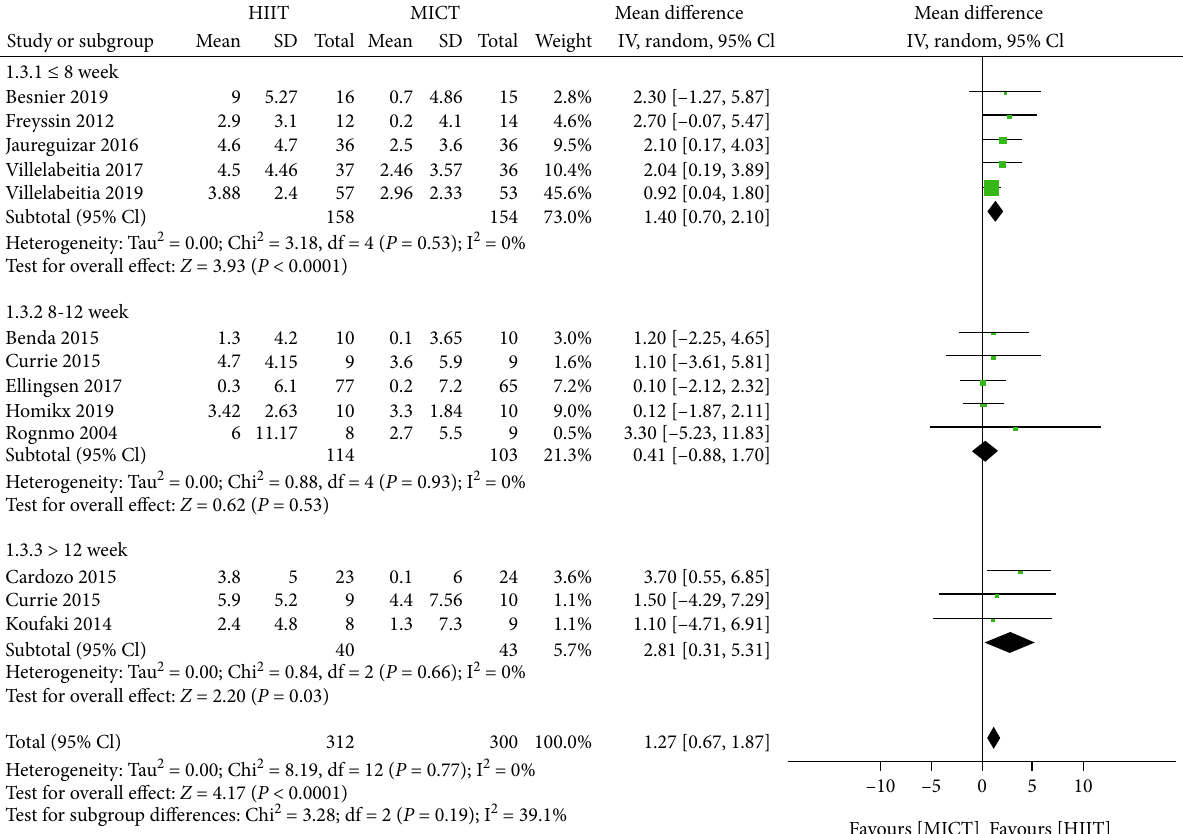
according to training duration ( ≤ 8weeks, 8-12weeks, and ≥ 12weeks). HIIT: 2 : peak oxygen consumption; CAD: coronary artery 2